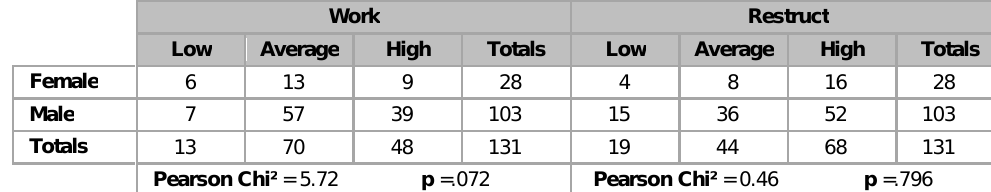
Table 4 indicates the cross-tabulations per gender for Work Involvement and